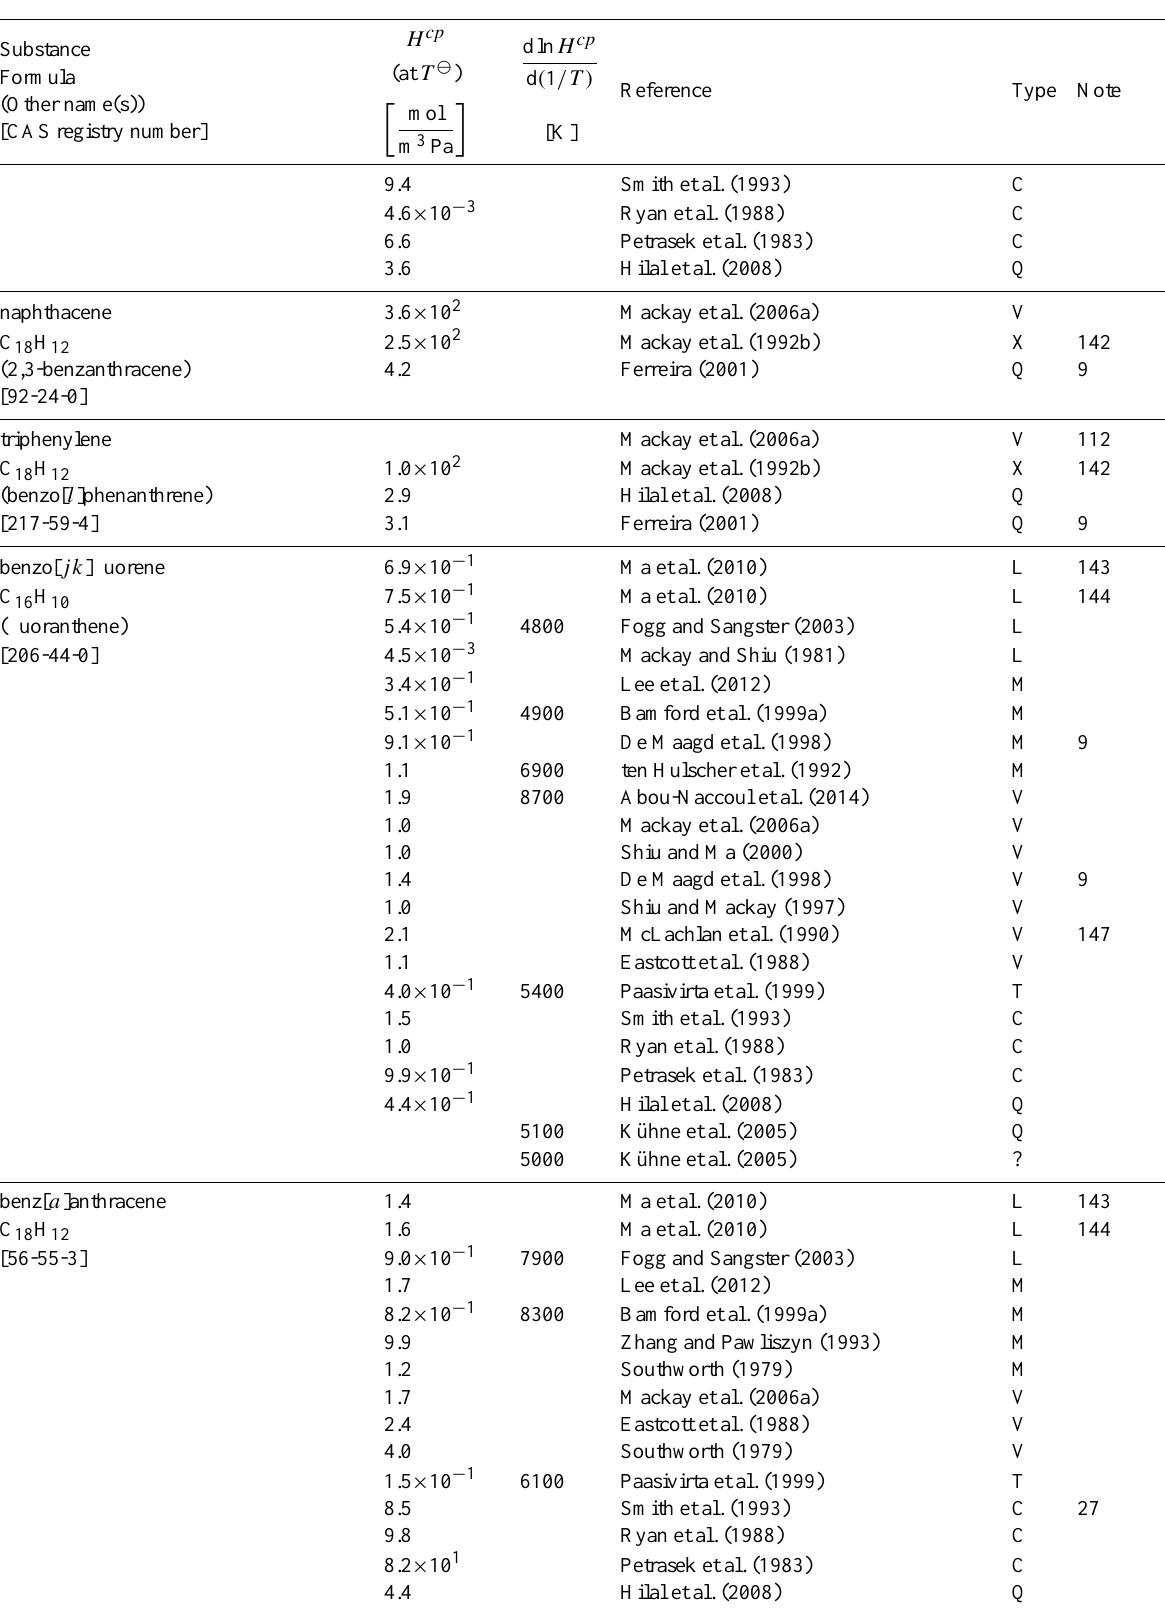
Table 6: Henry’s law constants for water as solvent